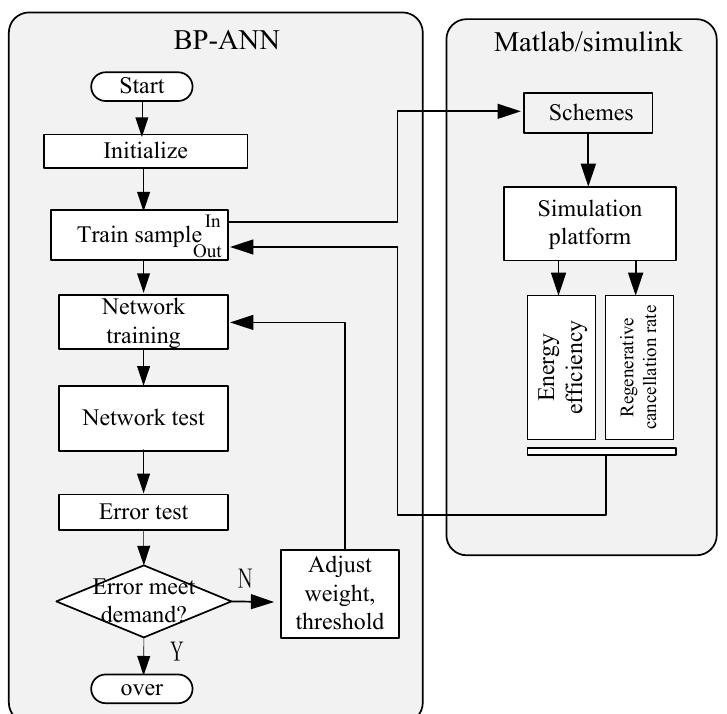
Figure16. BP-ANN flow